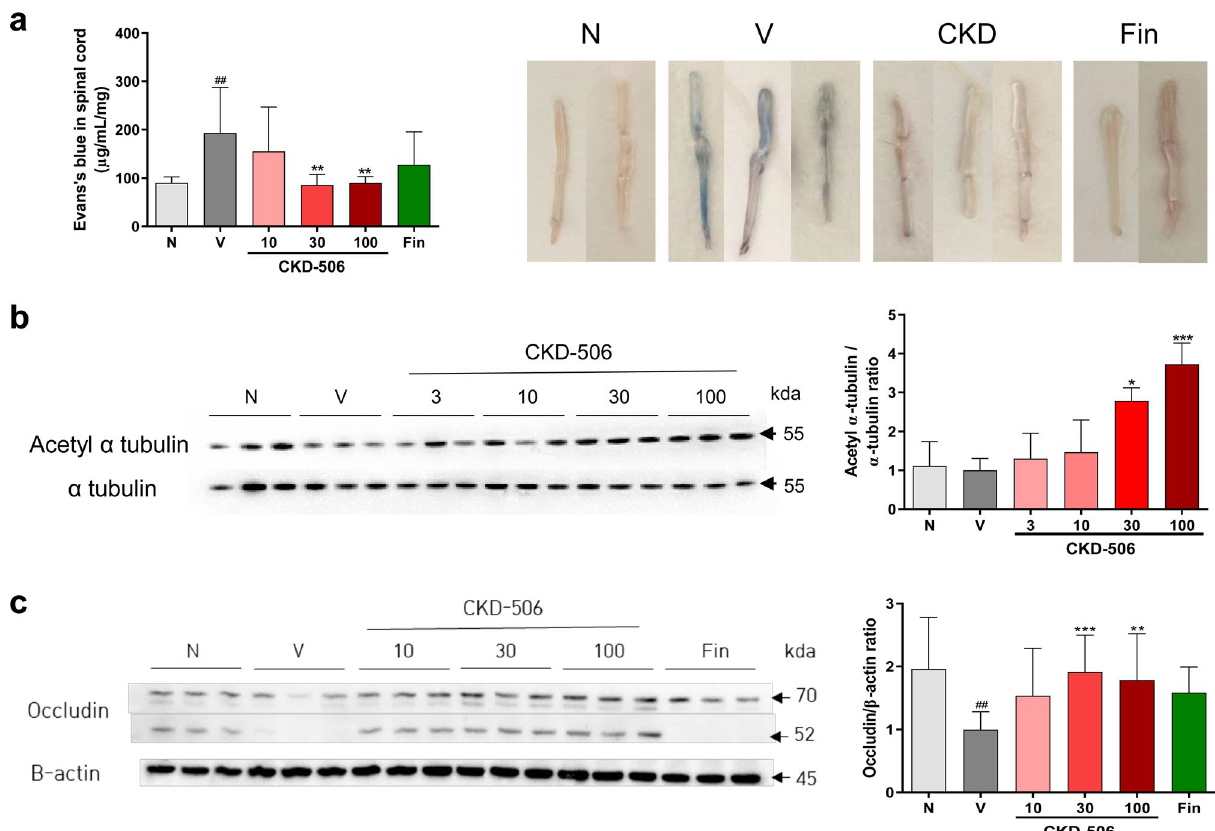
Figure 5. CKD-506 protected blood–brain barrier integrity in mice with experimental autoimmune encephalitis (EAE) by upregulating occludin expression. Mice were treated with CKD-506 (10, 30, or 100 mg/ kg bodyweight) and fingolimod (0.3 mg/kg bodyweight) from day 6 post-EAE induction. The volume of Evans blue dye and the levels of acetylated α-tubulin and occludin in the spinal cord were analyzed 15 days later ( a – c ). The infiltration of Evans blue dye in the spinal cord of mice with EAE was quantified 1 h after the intravenous injection of the dye (n = 9 per group for the vehicle group; n = 8 per group for the other groups). Additionally, the protein expression levels of acetylated α-tubulin (n = 3 per group) ( b ) and occludin [n = 8 per group for the non-immunized groups and fingolimod (1 mg/kg) treated group, n = 14 per group for the other groups] ( c ) in the spinal cord of mice with EAE were evaluated 1 h after the final drug administration on day 21 post- induction. Data are presented as mean ± SD and analyzed using one-way ANOVA, followed by Dunnett’s post- hoc test. # p < 0.05, ## p < 0.01, non-immunized groups versus vehicle group; * p < 0.05, ** p < 0.01, and *** p < 0.001, drug-treated group versus vehicle group. N, non-immunized groups; V, vehicle group; Fin, fingolimod (0.3